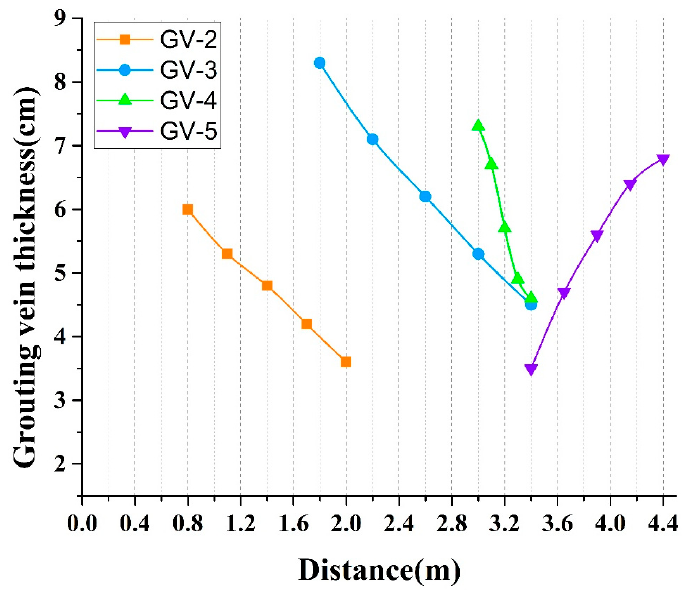
Figure 16. Measured value of the grouting veins. GV: Grouting vein.